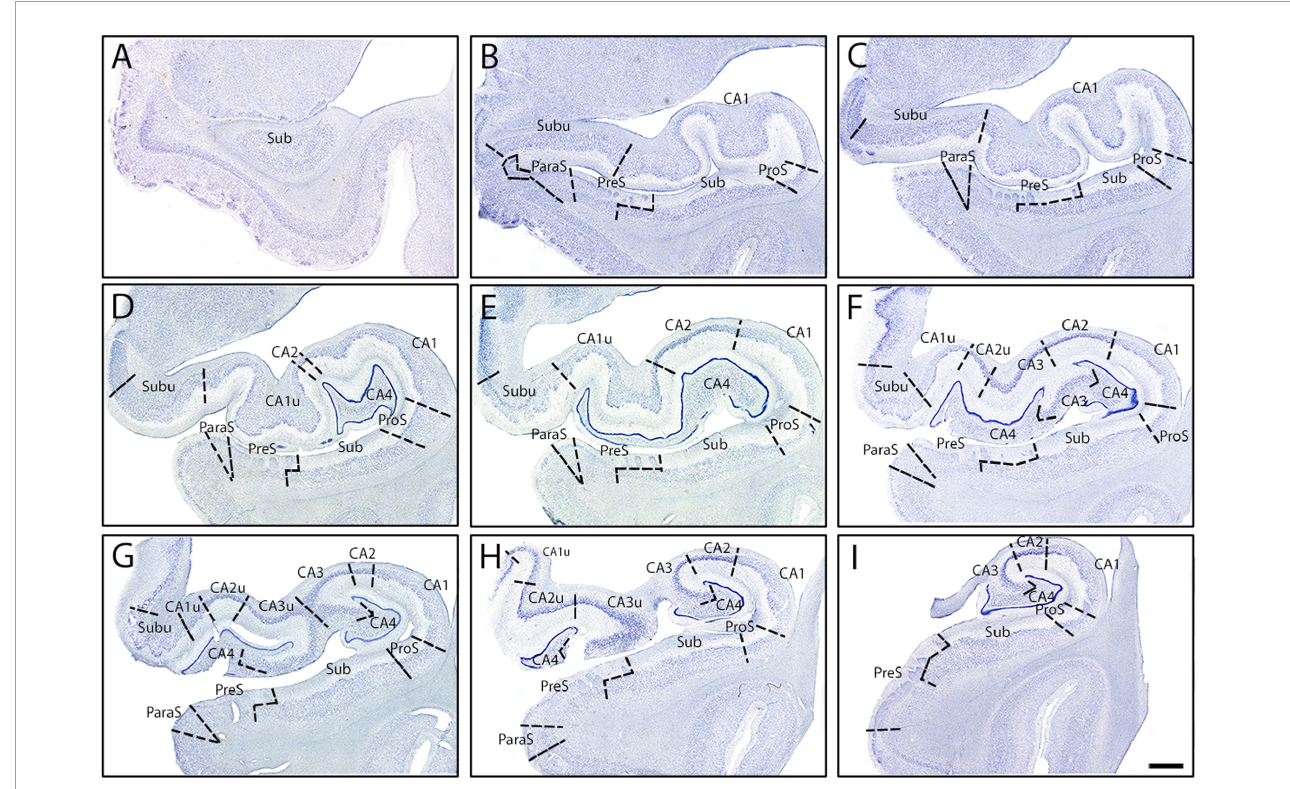
FIGURE7 Parcellated human hippocampus from rostral to caudal levels from one case (Case 17). Panels (A–I) shows Nissl stained sections from each of the nine established levels (see Figure 1 ): genu (A) , genu-pes (B) , pes (C) , pes-DG (D) , full DG (E) , separated DG (F) , x-region (G) , uncus-body (H) , and body (I) , respectively. (A) The start of the hippocampus, typically only Sub, CA1, and rarely PreS is present. (B) ProS, ParaS emerge by this rostrocaudal point, as well as Subu. (C) As pes show a definite shape, similar subfield parcellation to panel (B) . (D) CA2, CA4, and CA1u appear, as well as the DG. (E) CA2 and CA4 both become larger, while Subu reduces in territory. (F) CA3 present, as well as CA2u. (G) Uncinate gyrus (and uncus) separates from the hippocampal body, and Subu and CA1u continue to get smaller. (H) ParaS and PreS shift more medially, Subu has disappeared. (I) ParaS and all medial subfields have ended. Note how subfields fluctuate in size (i.e., medial-lateral width) as hippocampus moves anterior to posterior. Magnification bar, 2